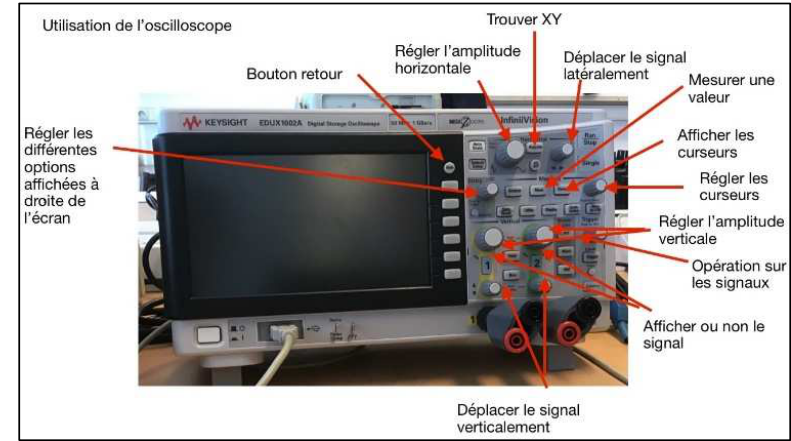
Figure 3. Annotations d’une photographie présentant les fonctionnalités d’un